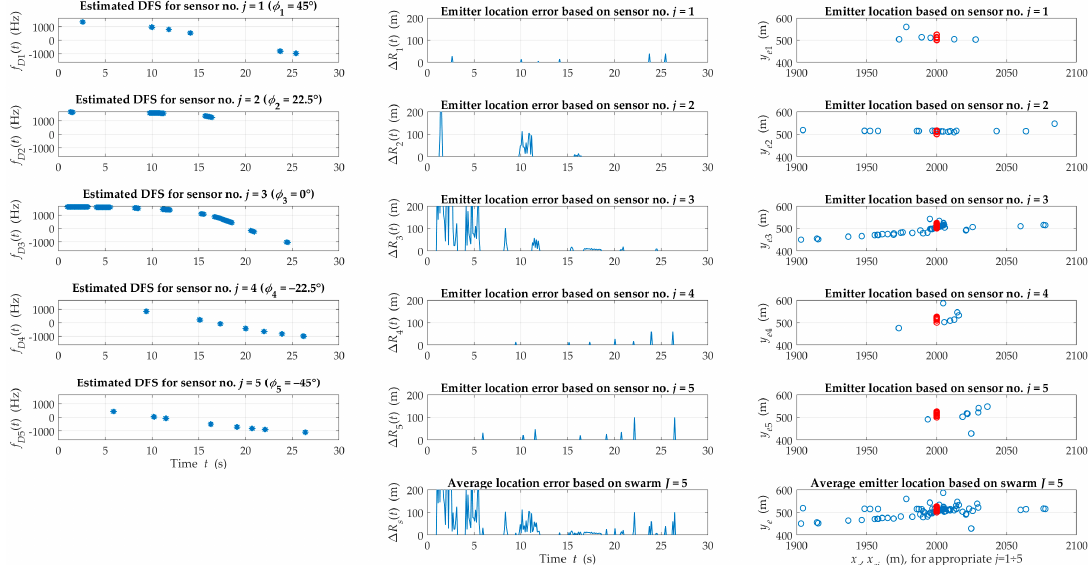
Figure 6. Examples of instantaneous DFS, location errors and the estimated emitter position obtained based on the individual sensors and swarm for an urban area.